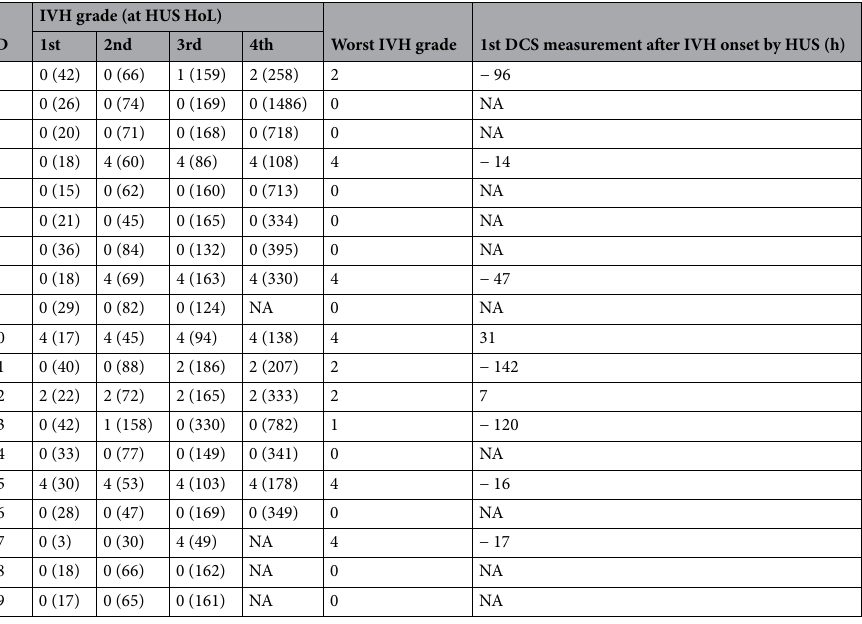
Table 4. Individual HUS exams and IVH status with respect to our measurement. HUS Head ultrasound, HoL Hours of Life. NA not available, not applicable, or not